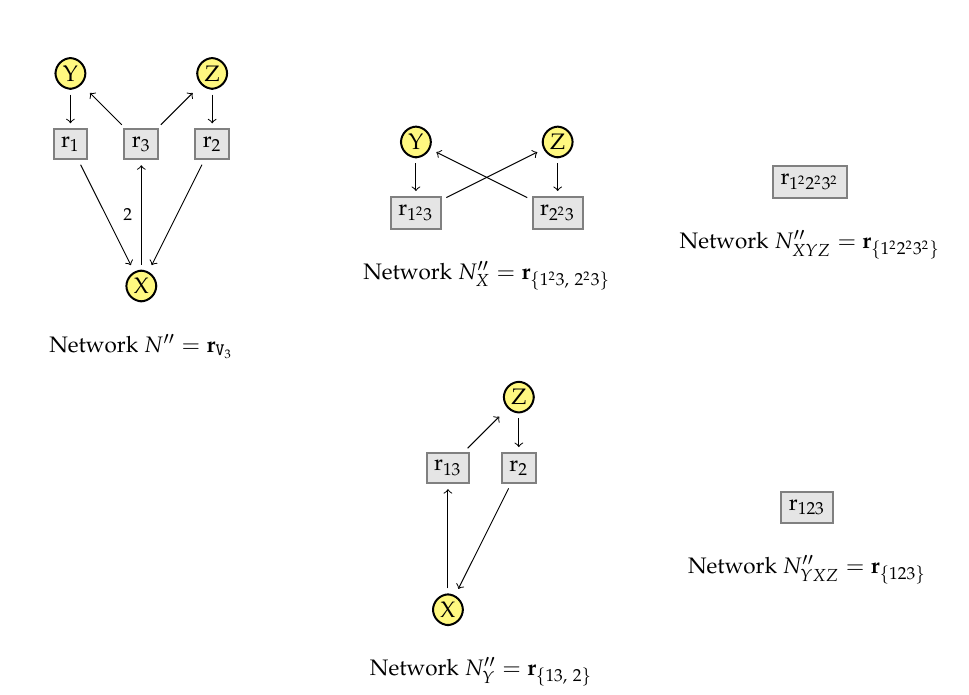
Figure 10. Elimination of intermediate species from flux networks in different orders is not confluent without